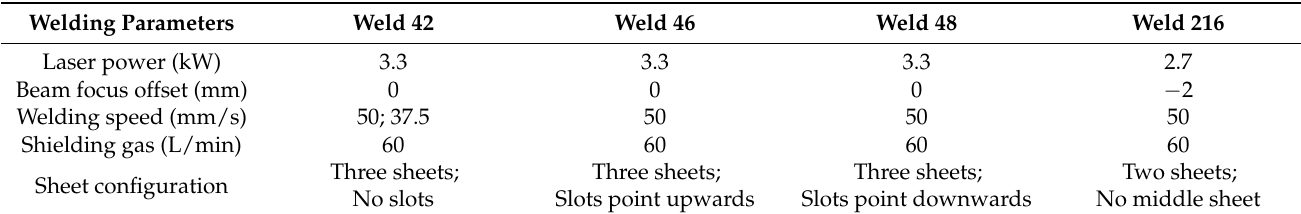
Figure 13. The metallographic characterization, the resulting ground truth data and the classification results for weld 216 based on the proposed ensemble CNN-GRU architecture. Table 4. Parameters and sheet configuration of four welding experiments for